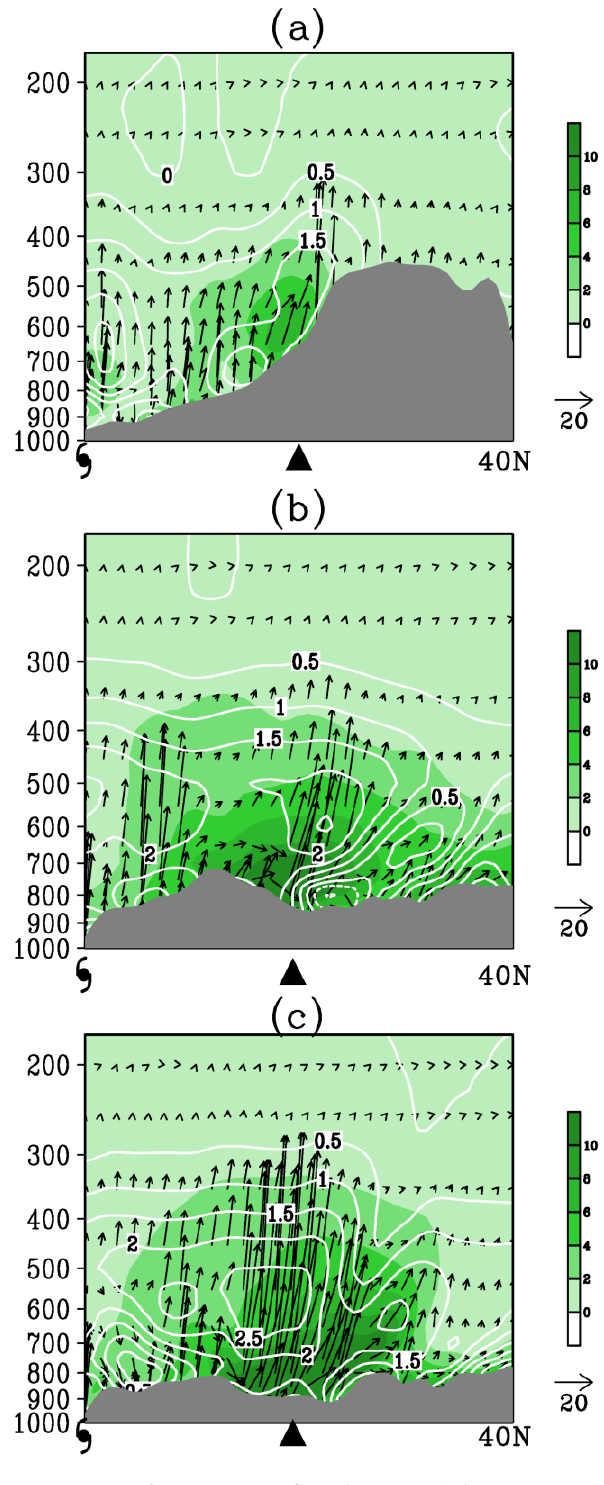
Figure 9. Vertical cross-sections of water vapor flux (horizontal direction vector, units: 10 − 2 m s − 1 , vertical direction units: 10 − 5 m s − 1 ), magnitude of water vapor flux (shaded, unit: 10 − 2 m s − 1 ), and anomalous specific humidity (contour, unit: g kg − 1 ) along the red dotted line segments shown in Figure 8b,e and f on ( a ) 11 May 2002, ( b ) 12 May 2002, and ( c ) 13 May 2002, respectively. The locations of the tropical cyclones are indicated by black tropical storm symbols. The centers of maximum precipitation are indicated by triangle symbols.